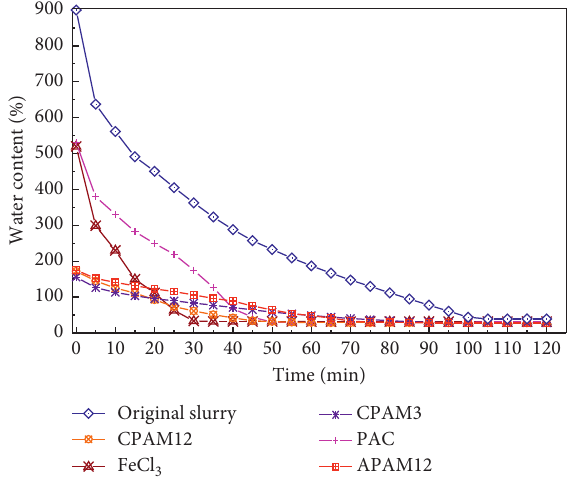
Figure 11: Water content change curve for slurry pressure fil- tration after flocculation. Table 4: Results of pressure filtration test.